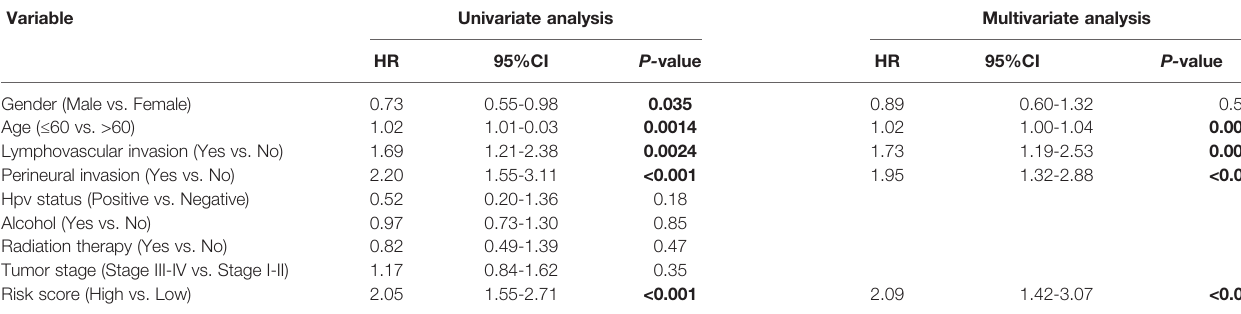
TABLE 2 | Univariate and multivariable Cox regression analysis of prognostic factors in 494 patients with HNSCC. Variable Univariate analysis Multivariate analysis